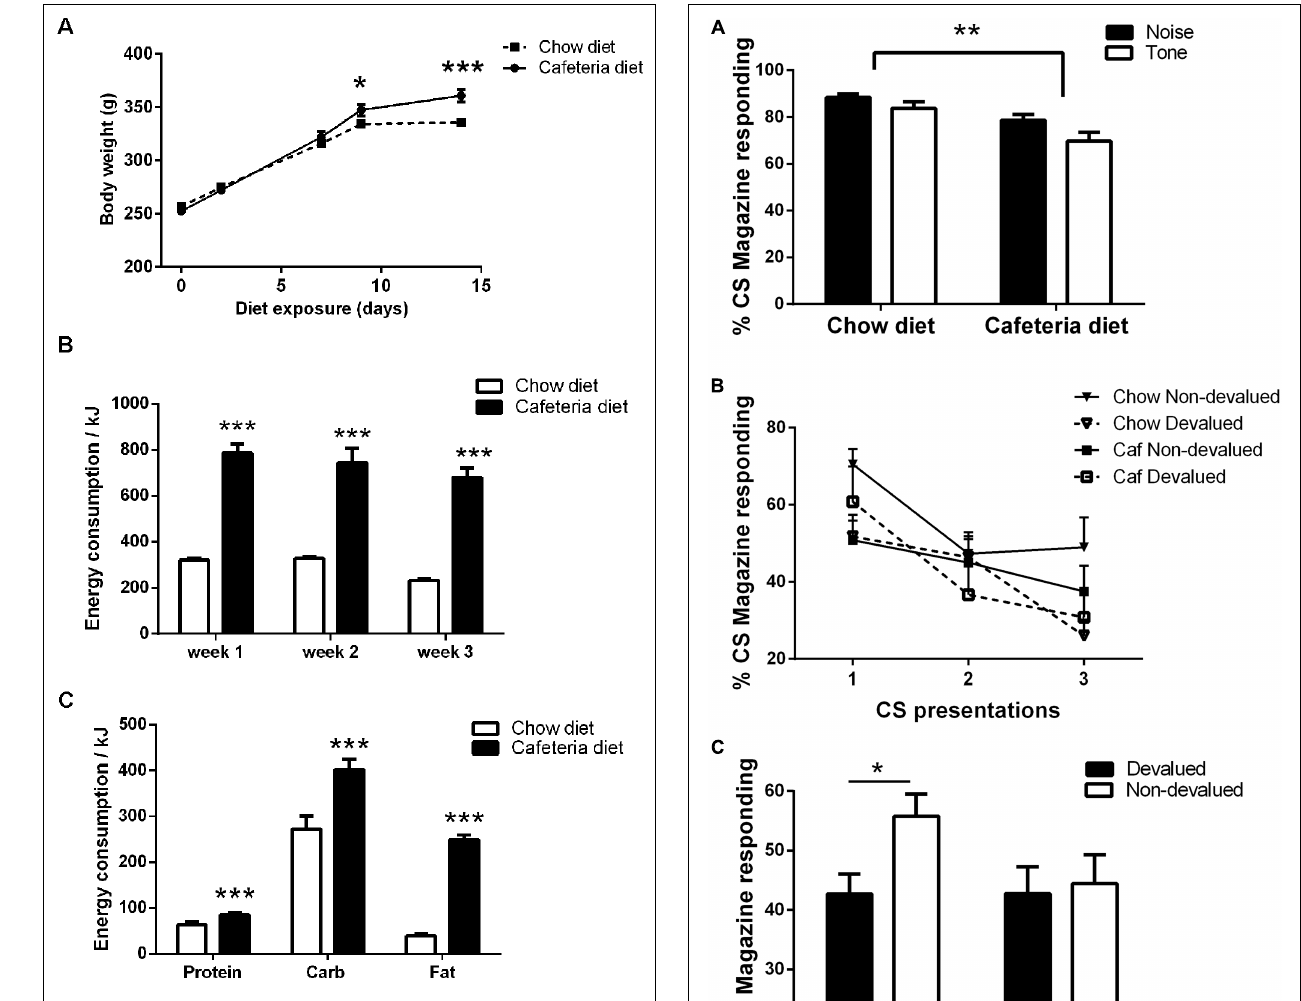
FIGURE 2 | (A) Body weight of cafeteria ( N = 16) and chow ( N = 16) diet rats. (B) Total energy intake over 24 h (kJ/rat). (C) Macronutrient intake over 24 h (protein, carbohydrate, and fat) as energy (kJ/rat). Data presented as mean ( ± SEM). * p < 0.05, *** p ≤ 0.001 compared to chow, Bonferroni corrected. Figure 2B . Repeated measures ANOVA between subject fac- tors of diet (cafeteria, chow) and within subject factor of diet exposure (week) revealed a significant main effect of diet, F (1,3) = 433.4, p < 0.001, no significant main effect of diet expo- sure, F (2,6) = 3.5, p = 0.097, and no significant diet x exposure interaction, F < 1. As shown in Figure 2C , rats fed the cafe- teria diet consumed significantly more energy (kJ) as protein, ( t = 8.4, df = 6, p < 0.001), carbohydrate, ( t = 8.0, df = 6, p < 0.001), and fat, ( t = 21.7, df = 6, p < 0.001), than chow fed rats.